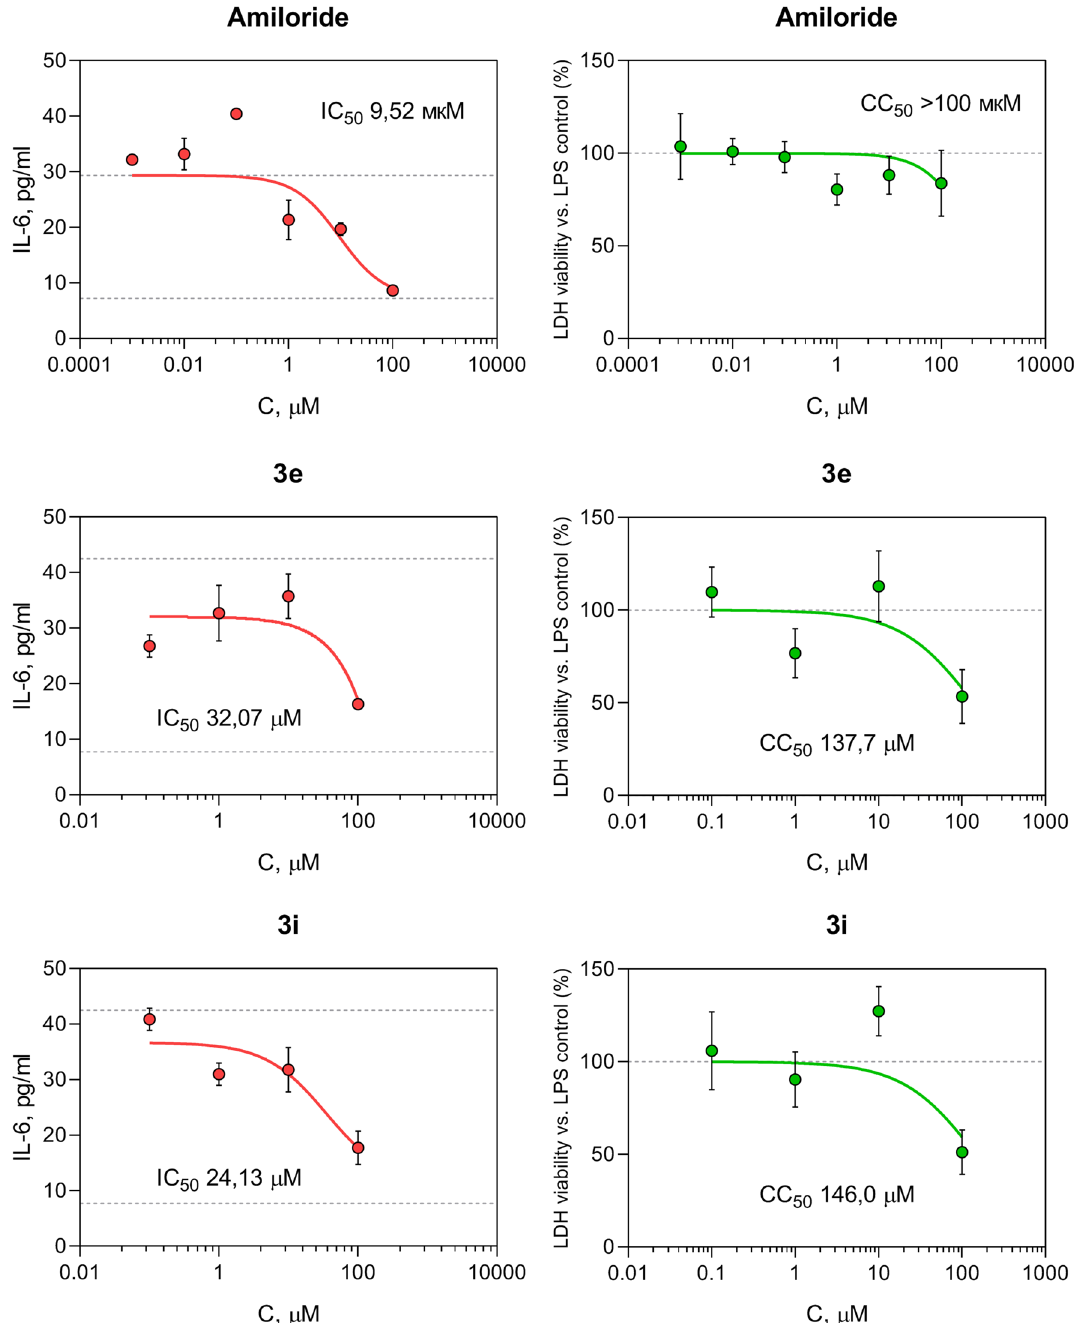
Figure 5. Lead compounds prevent IL-6 secretion from LPS-stimulated murine